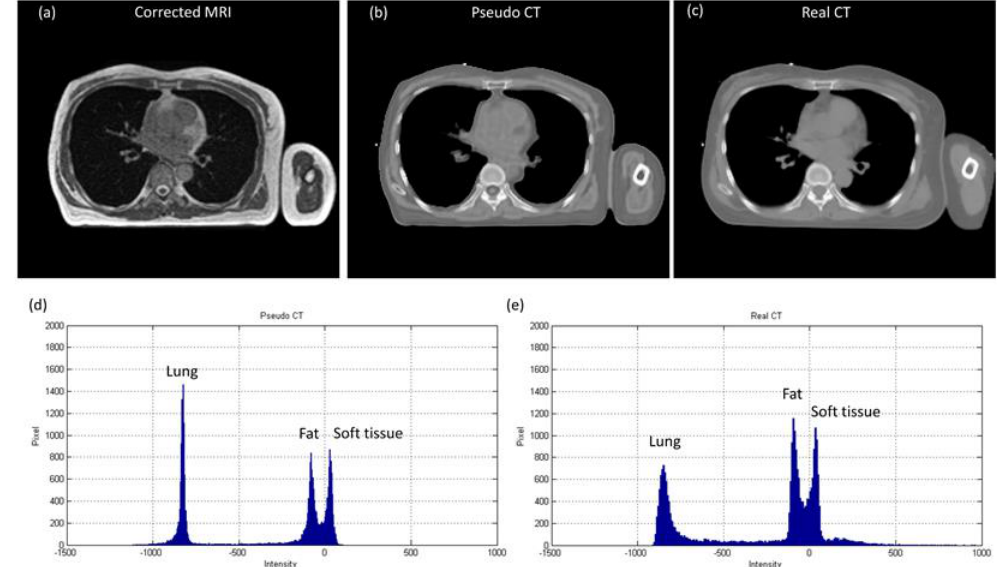
Figure 8. ( a ) Corrected MRI from 0.35 T scanner (WL/WW = 100/200), ( b ) pseudo-CT (WL/WW = 0/1000), ( c ) real CT (WL/WW = 0/1000), ( d ) histogram of pseudo-CT, and ( e ) histogram of real CT for chest imaging divided into CNN testing dataset ( IMG testingchest ).